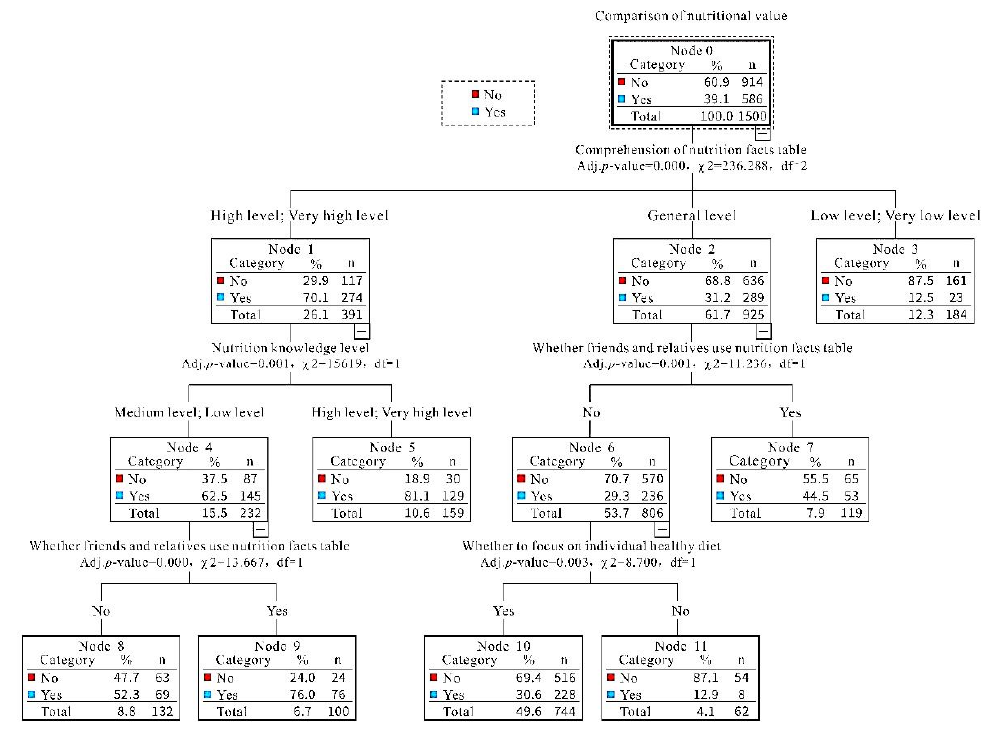
Figure 1. Results of Decision Tree Analysis based CHAID algorithm. Note: n (number); df (degree of freedom); χ 2 (chi-square); Adj. p -value (adjusted p- value).